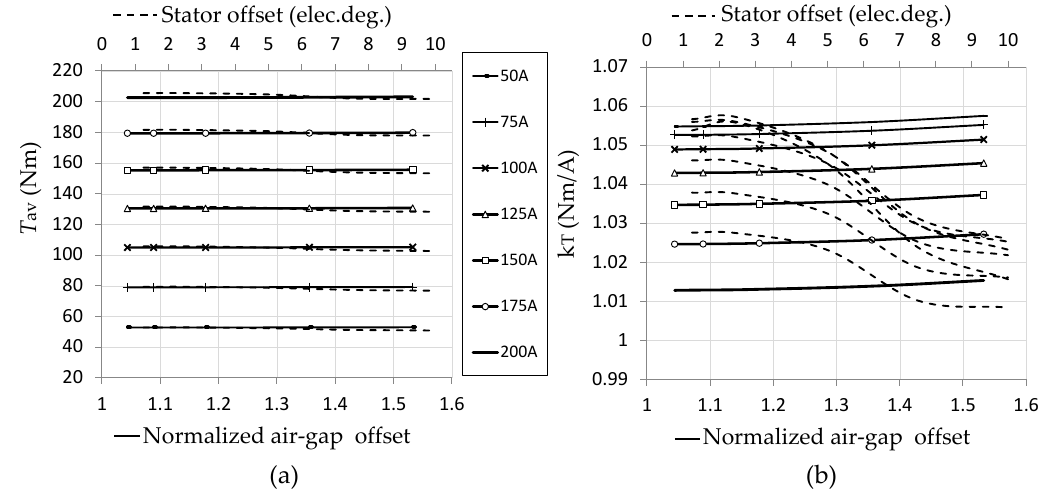
Figure 10. Normalized air-gap offset (solid line), and stator offset (dotted line) vs.: ( a ) Electromagnetic torque T av ; ( b ) torque constant k T . Energies 2019 , 12 , x FOR PEER REVIEW